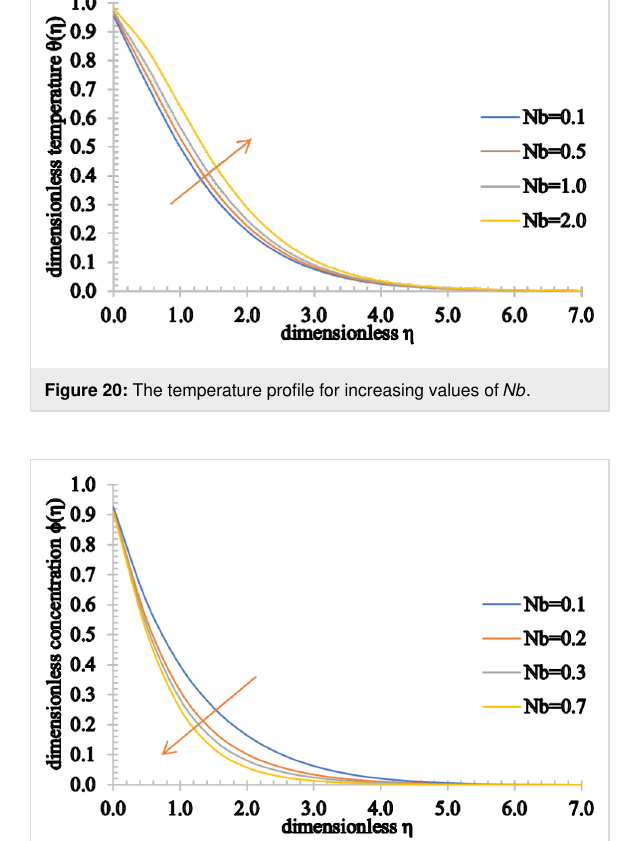
increases. In addition, the associated thermal and concentration boundary layer thickness values are enhanced.